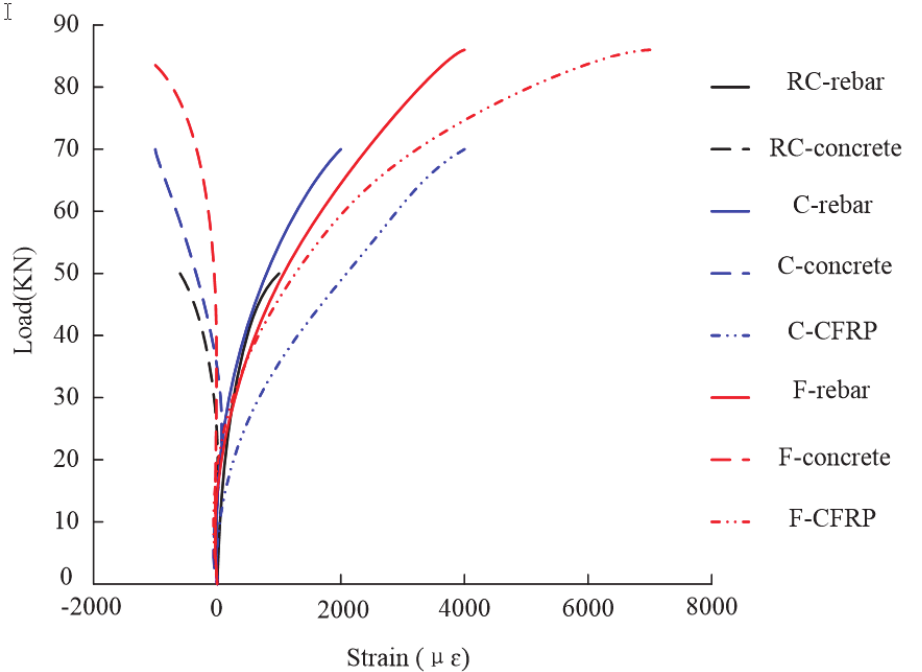
Figure 6: The comparison results of strains of different